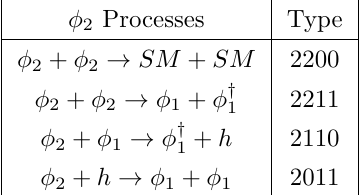
Table 1 . The 2 → 2 processes that are allowed in the Z 4 model and that can modify the relic density of φ 1 (left) and φ 2 (right). h denotes the SM Higgs boson. Conjugate and inverse processes are not